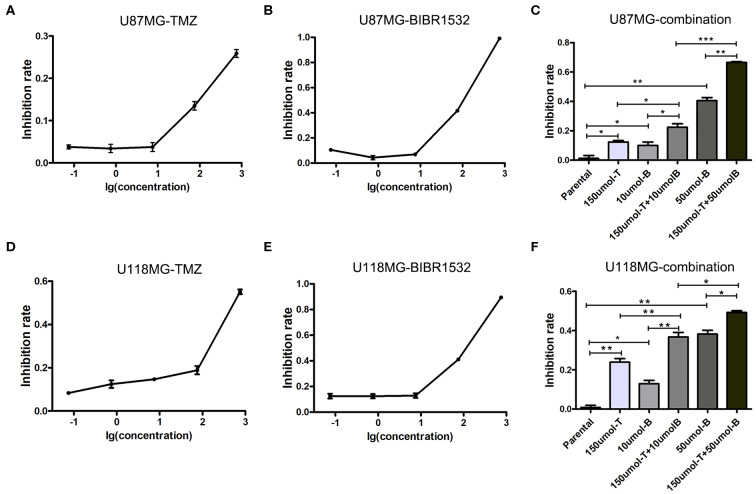
Inhibition of U87MG and U118MG cell lines using TMZ and BIBR1532. (A–C) Single treatment and combination treatment with TMZ and BIBR1532 of U87MG cell line. (D–F) Single treatment and combination treatment with TMZ and BIBR1532 of U118MG cell line. Data are presented as the mean ± SD. *P < 0.05; **P < 0.01; ***P < 0.001.